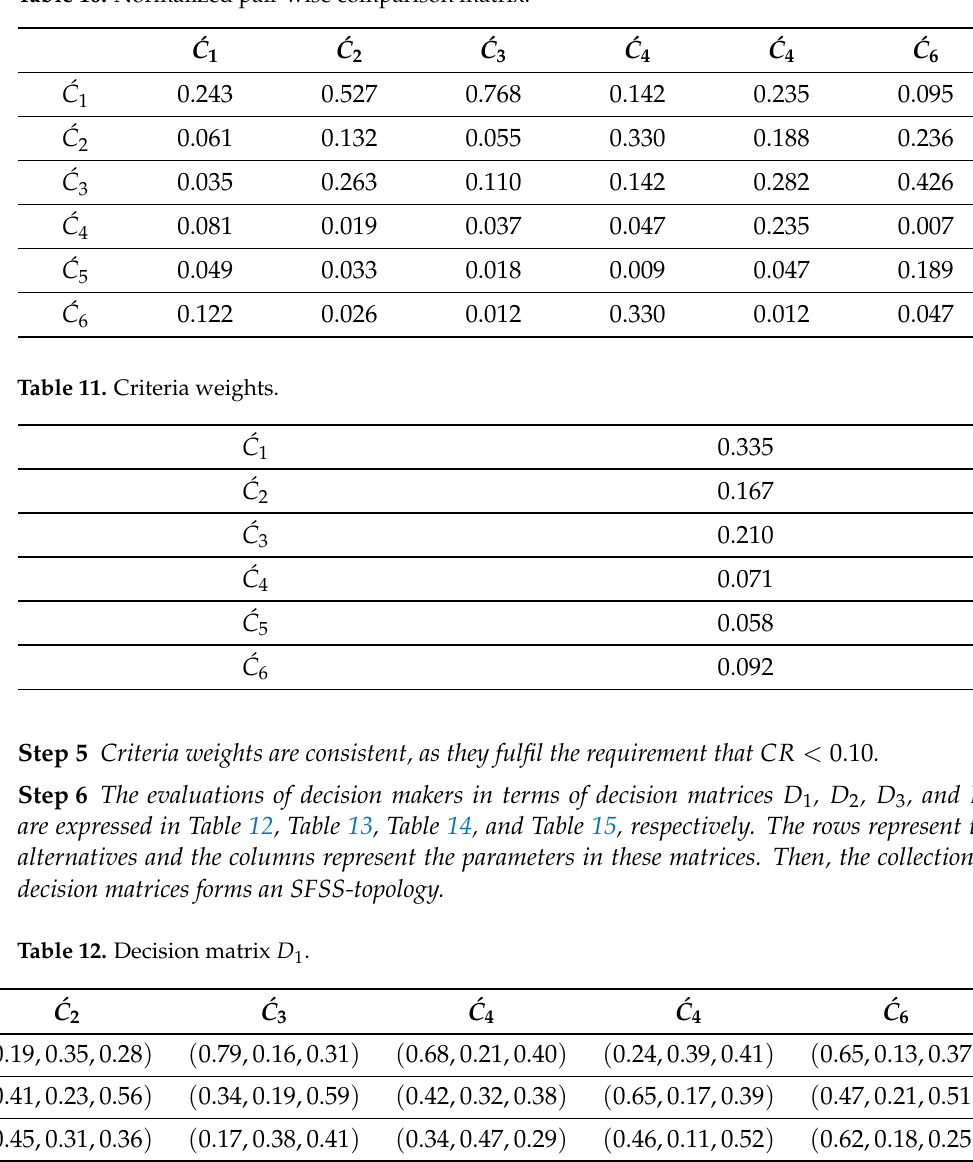
Table 10. Normalized pair-wise comparison matrix.